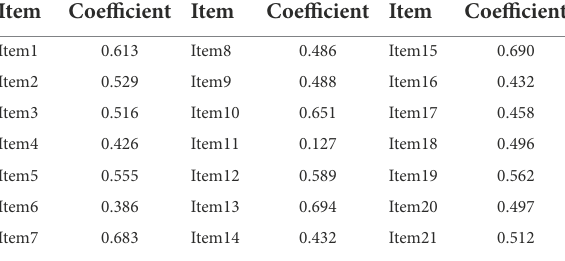
TABLE 3 The common factor loading coefficient.